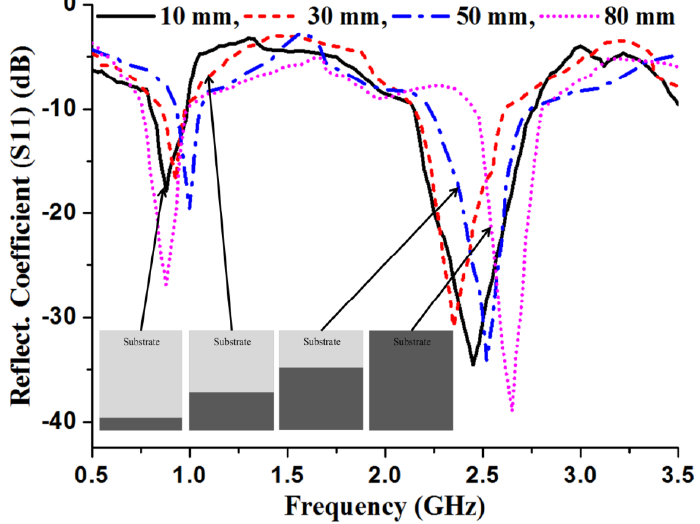
Figure 3. Effect of ground plane length on reflection coefficient of the proposed antenna.